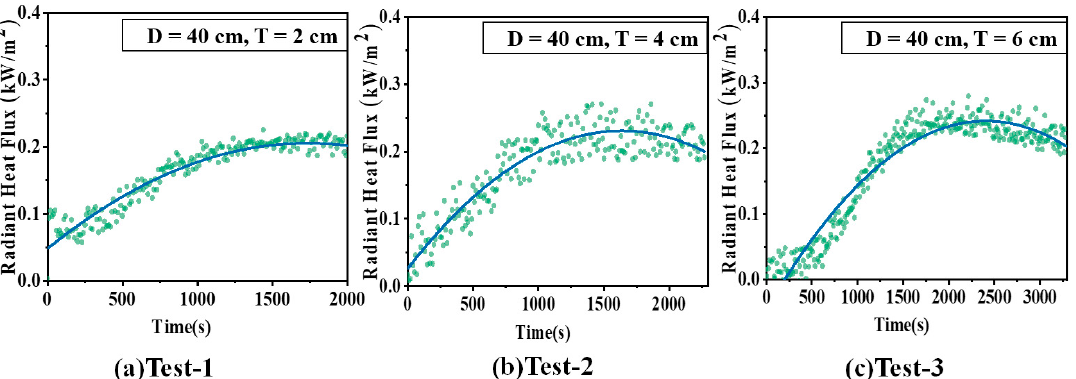
Figure 11. The radiant heat flux changes from Test-1 to Test-3 (where ( a ) is a coal pile of 40 cm diameter and 2 cm thickness, ( b ) is a coal pile of 40 cm diameter and 4 cm thickness, ( c ) is a coal pile of 40cm diameter and 6 cm thickness).